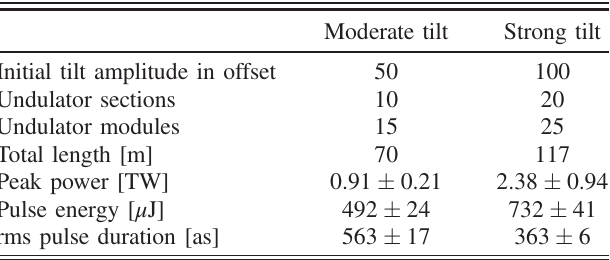
TABLE II. Simulation results for the two different tilt amplitudes.